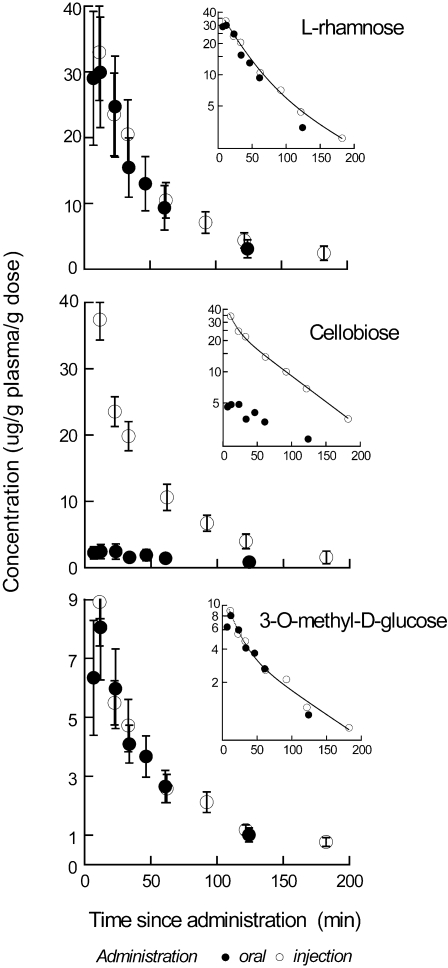
Pharmacokinetics of carbohydrates in plasma after oral administration and injection.Plots of mean (±s.e.m.) plasma L-rhamnose (upper plot), cellobiose (middle) and 3-O-methyl-D-glucose (lower plot) concentration as a function of time since each compound was consumed (oral) or injected into bats (n = 8). Each concentration (µg g−1 plasma) was normalized to the dose administered to the bat. Each inset displays the mean values on a semi-log plot. The line through points from the injection trial is the nonlinear fit to the biexponential model: Ct = A e−αt+B e−βt (see Methods, and Table 1 for derived parameters).